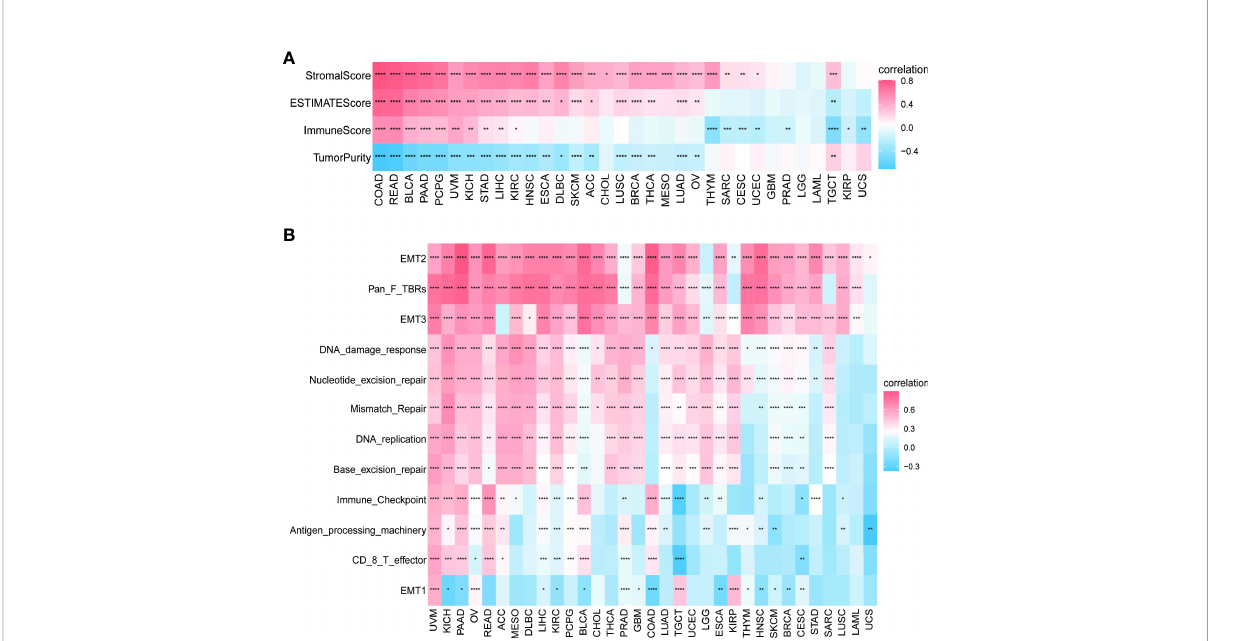
FIGURE 8 Relationship between PXDN expression and the tumor microenvironment. (A) Correlation between PXDN expression and stromal and immune scores. (B) Correlation between PXDN expression and tumor microenvironment-related pathways. Red and blue represent positive and negative correlations, respectively, while white represents p > 0.05. *p < 0.05, **p < 0.01, ***p < 0.001, ****p <